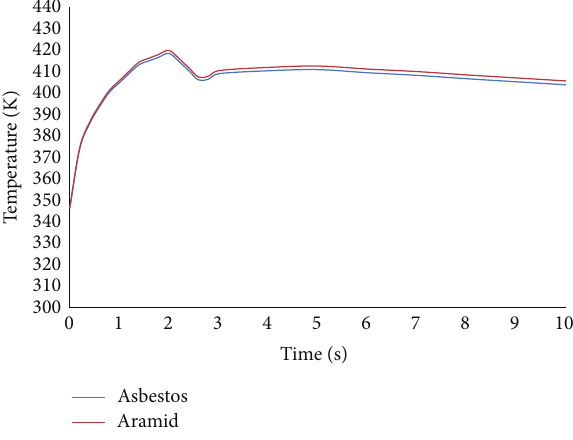
Figure 8: Temperature distribution for GCI disc and asbestos pad at 𝑡 = 2 seconds.